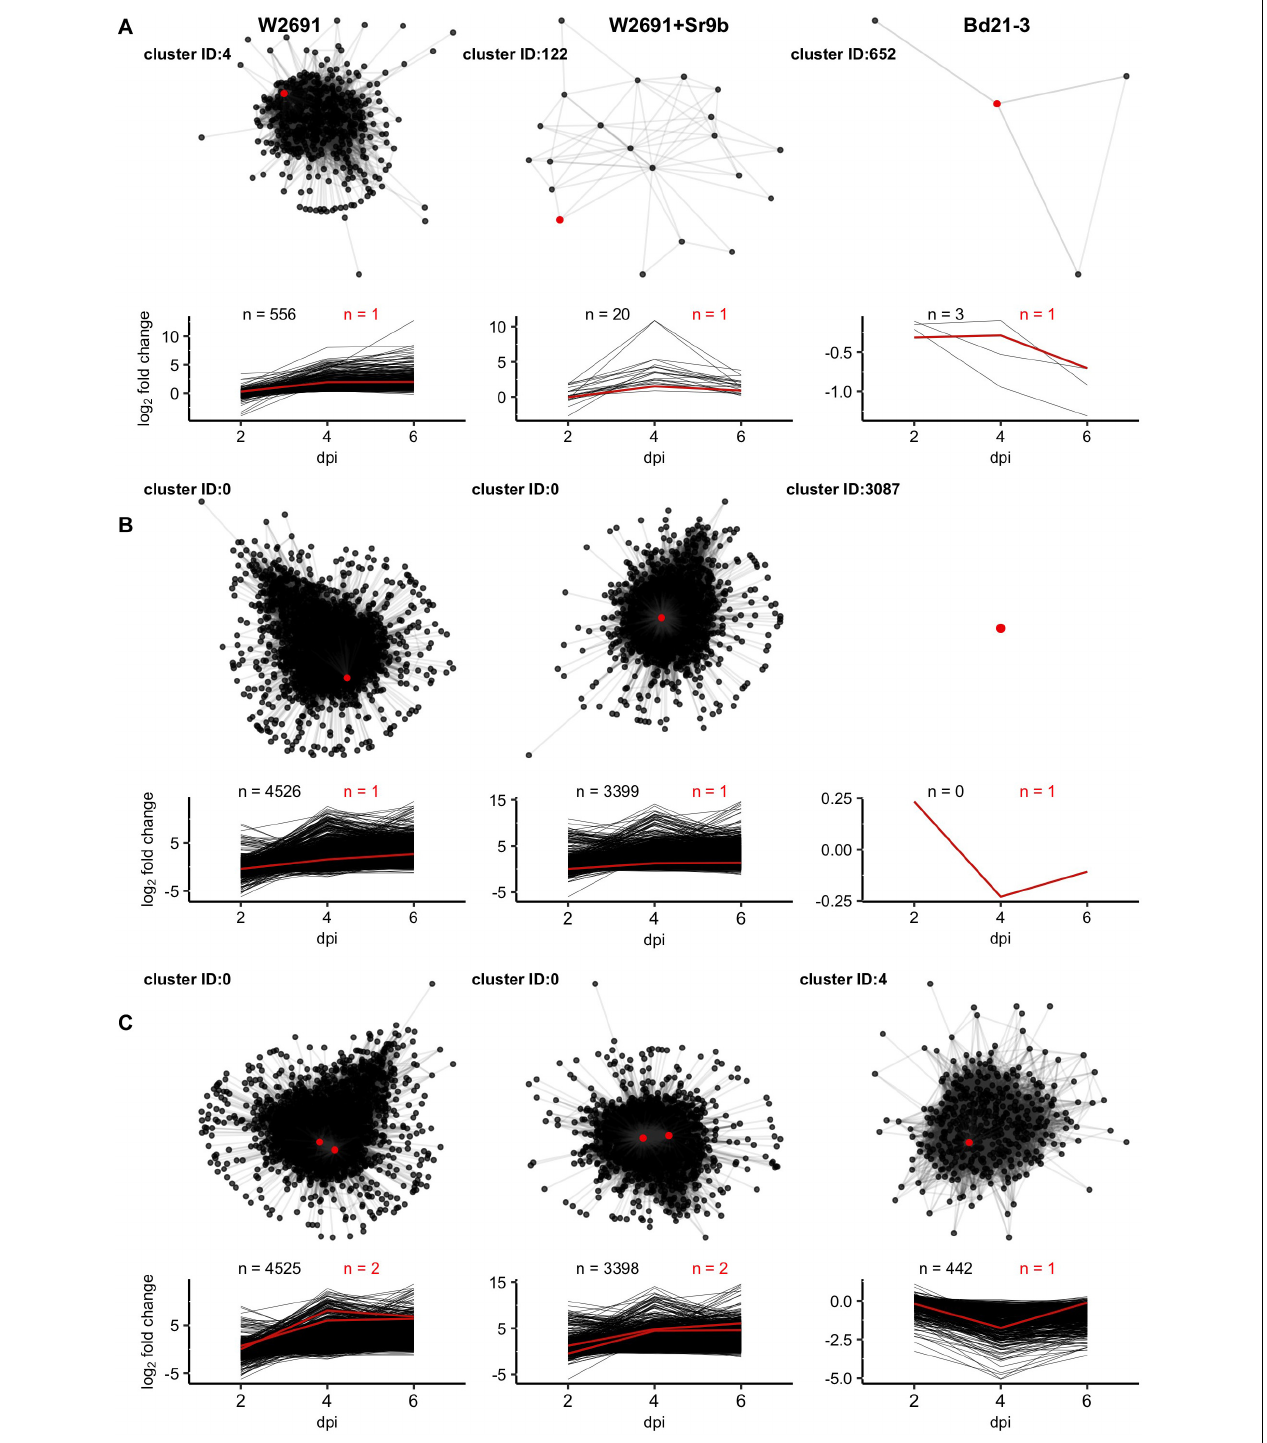
FIGURE 6 | Network diagrams for clusters containing orthologs of (A) DND1 , (B) VAD1 , and (C) DMR6 with corresponding plots showing log2 fold change of all nodes across 2, 4, and 6 dpi. Only connections with Z > = 3 are shown. Red lines, points, and counts represent T. aestivum and B. distachyon orthologs of S genes. Cluster identifiers (IDs) and gene names presented, left to right: DND1: 4 (TraesCS5D02G404600), 122 (TraesCS5D02G404600), and 652 (BdiBd21-3.1G0110600); VAD1 : 0 (TraesCS2D02G236800), 0 (TraesCS2D02G236800), and 3085 (BdiBd21-3.1G0357000); and DMR6 : 0 (TraesCS4B02G346900), 0 (TraesCS4D02G341800), and 4 (BdiBd21-3.1G1026800).